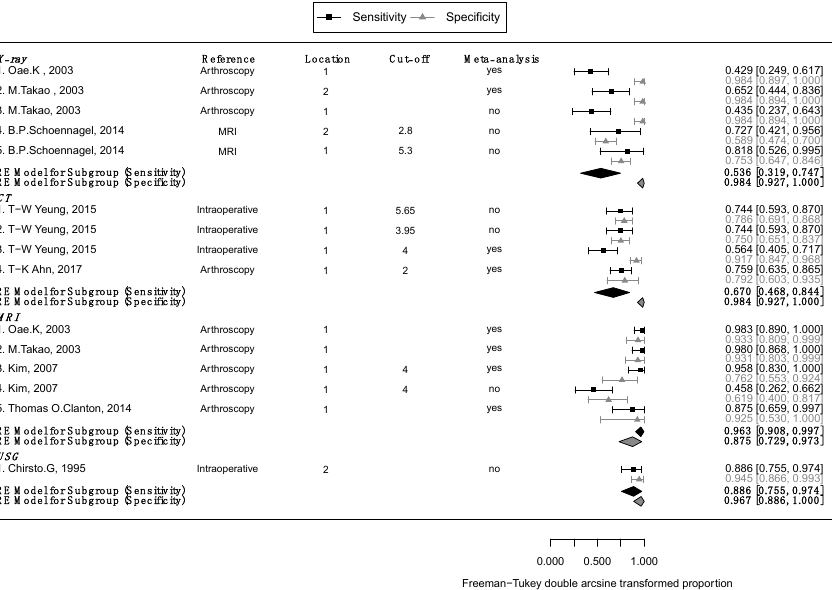
Figure 2. Subgroup meta-analysis and cumulative meta-analysis of each diagnostic methods.